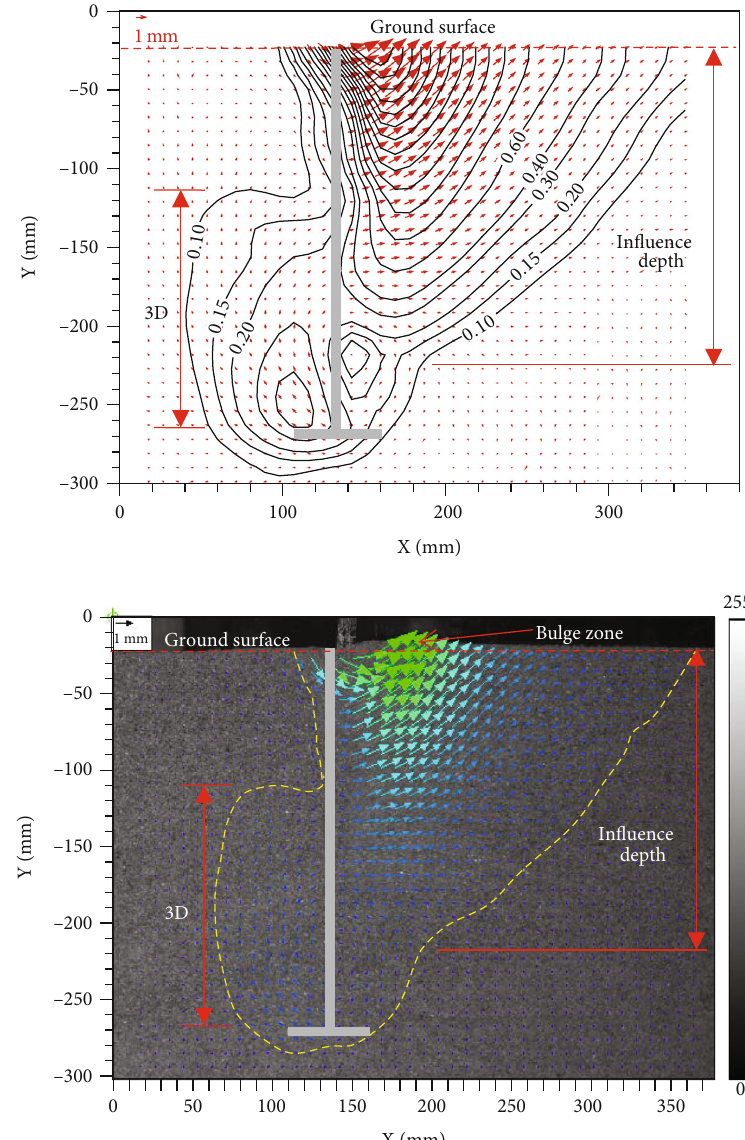
Figure 16: Displacement fi eld at the ultimate load for D